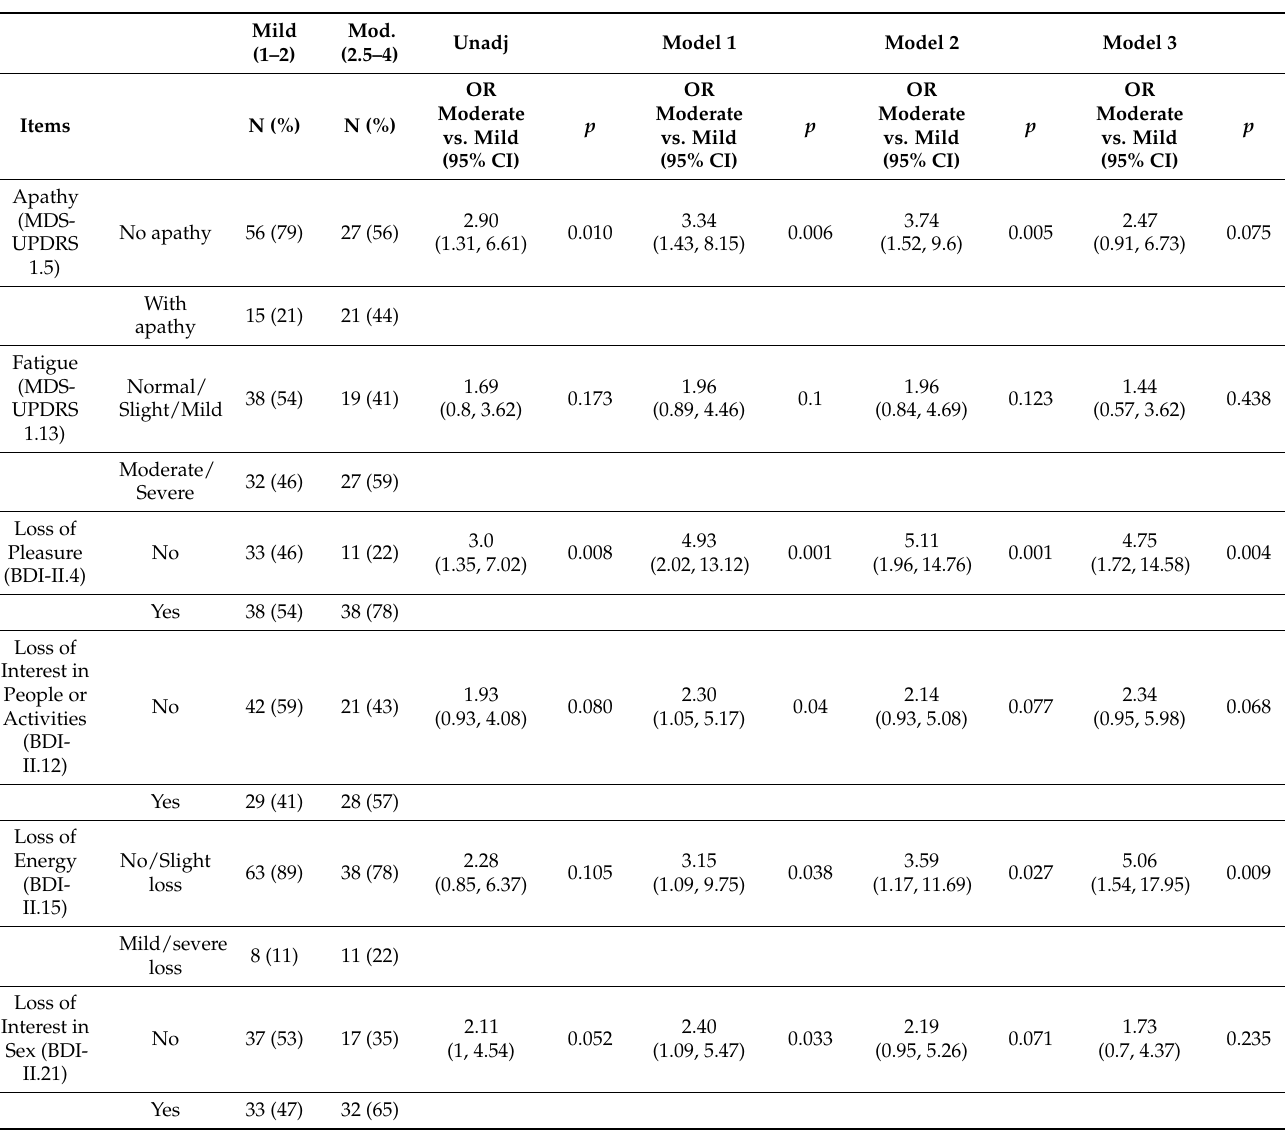
Table 3. Comparison of outcome variables between the mild group and moderate